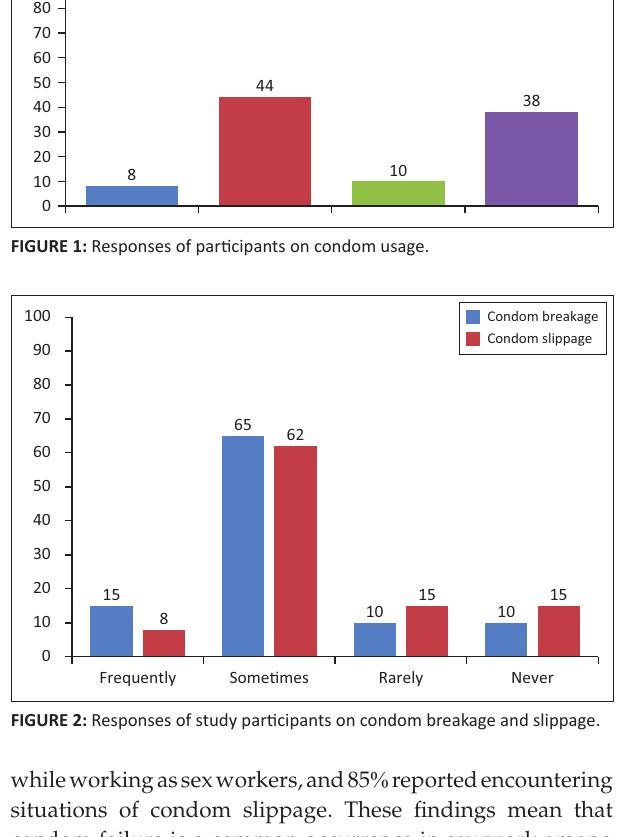
TABLE 1: Key demographics of study participants. Variable